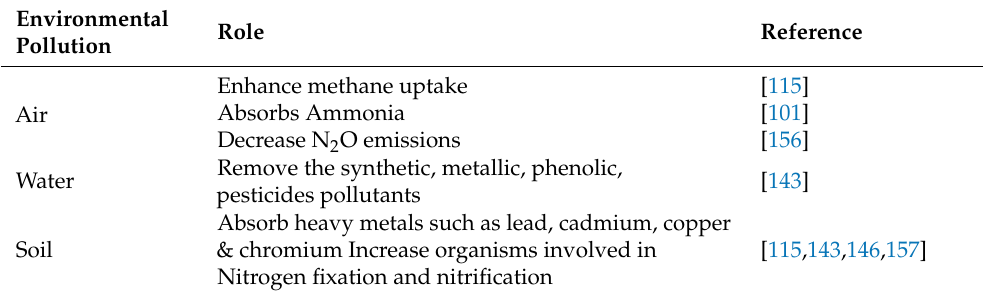
Table 4. Role of algal biochar in pollutants